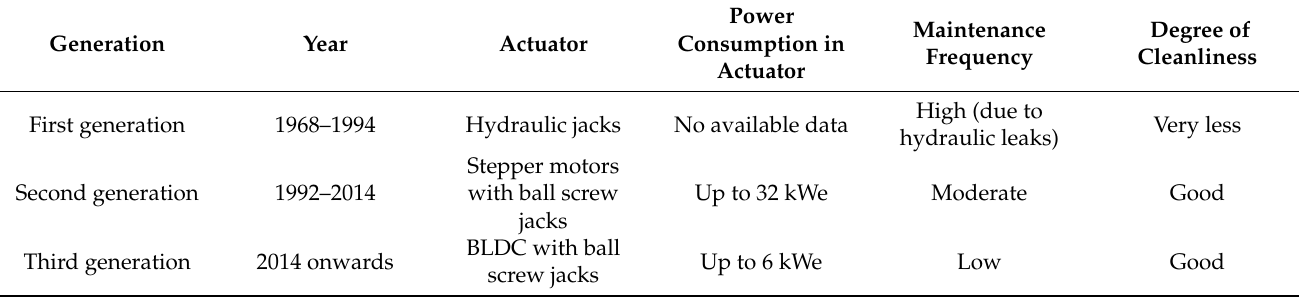
Table 2. Revolution in application of solar furnace actuator installed at Font Romeu